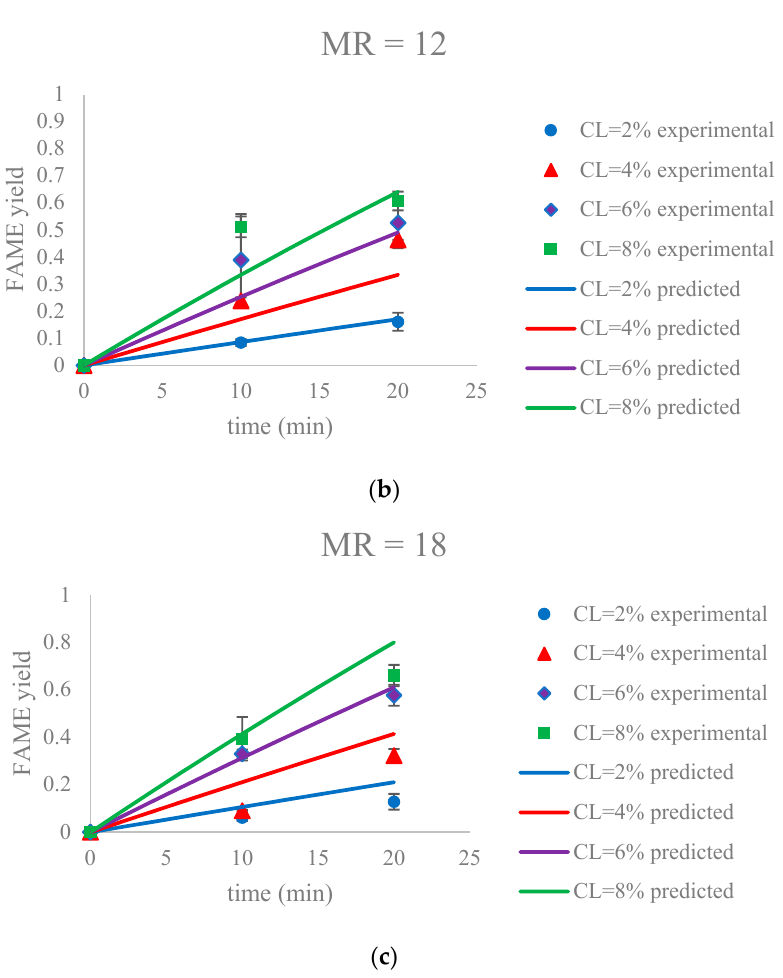
Figure 9. The FAME yield with the progress of the soybean oil transesterification catalyzed by Na-COS in the initial period (0–20 min) grouped by MR ( a ) MR = 6; ( b ) MR = 12; ( c ) MR = 18. Error bars represent standard error. Energies 2017 , 10 , 1920